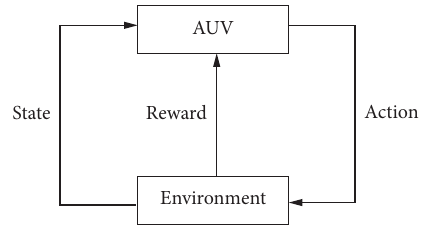
Figure 3: Application of reinforcement learning to